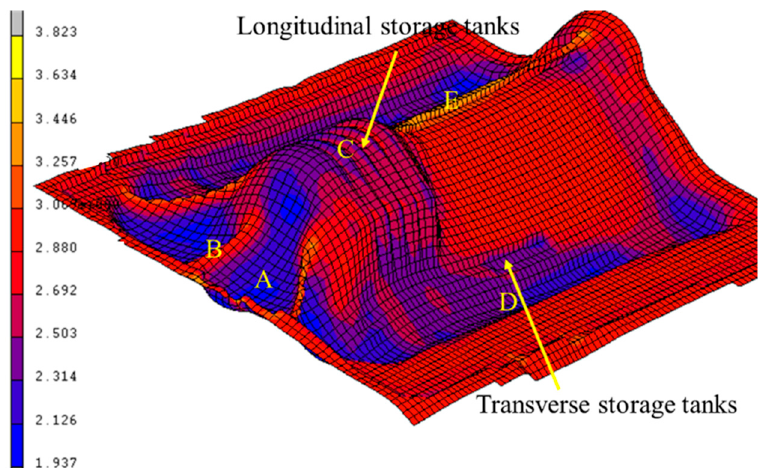
Figure 11. Thickness distribution of reverse bulging during the preforming process.